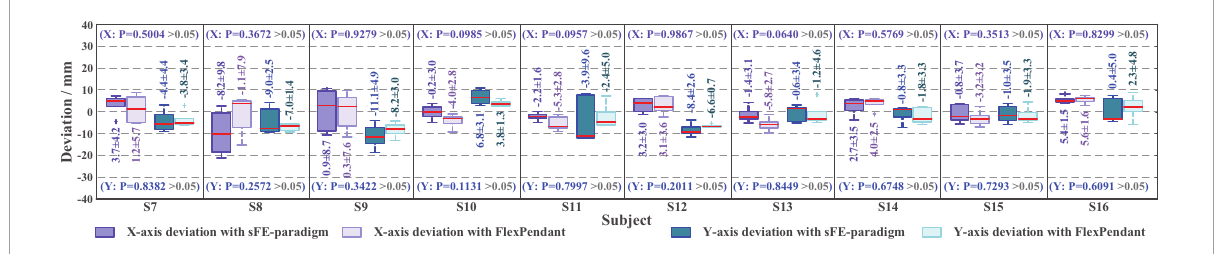
FIGURE19 The boxplot of placement deviation in Task one with slight-facial expression (sFE)-paradigm and FlexPendant, where the short red line indicates the median, and the number indicates the mean.